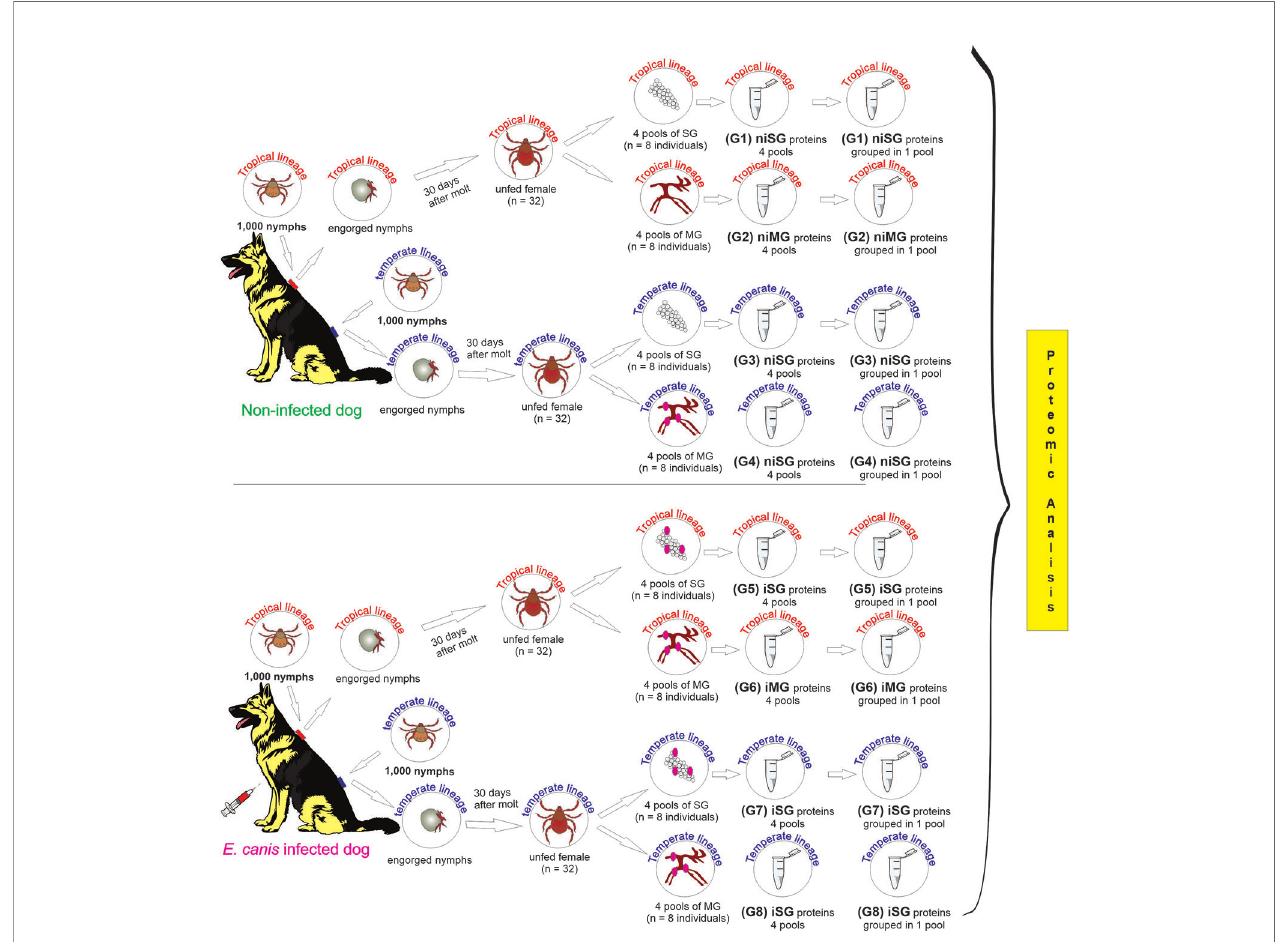
FIGURE 1 | Study schema outlining the derivation of the samples, and the experimental groups subjected to the proteomic analysis. ni, non-infected condition; i, infected condition; SG, salivary glands; MG, midgut; G1 – G8, experimental